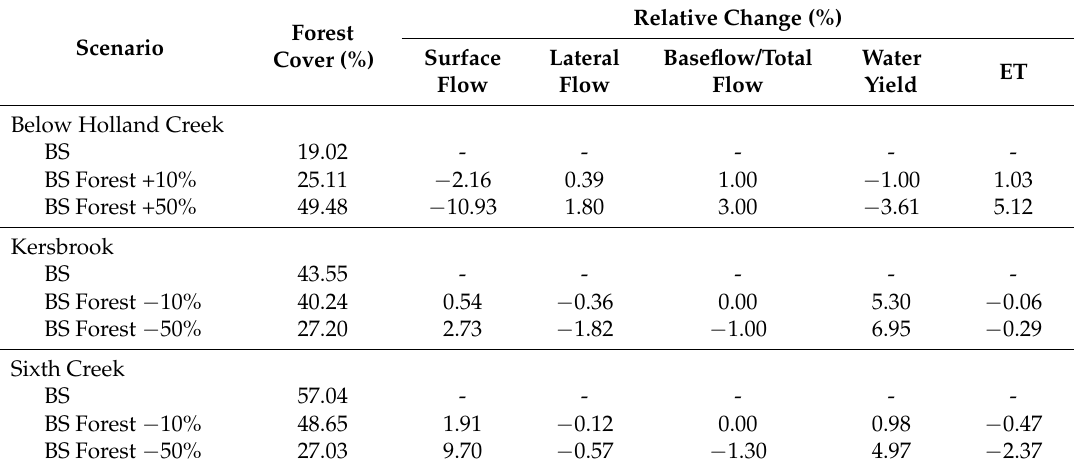
Table 4. Scenarios on effects of forest cover on streamflows during the period from 2007 to 2014.